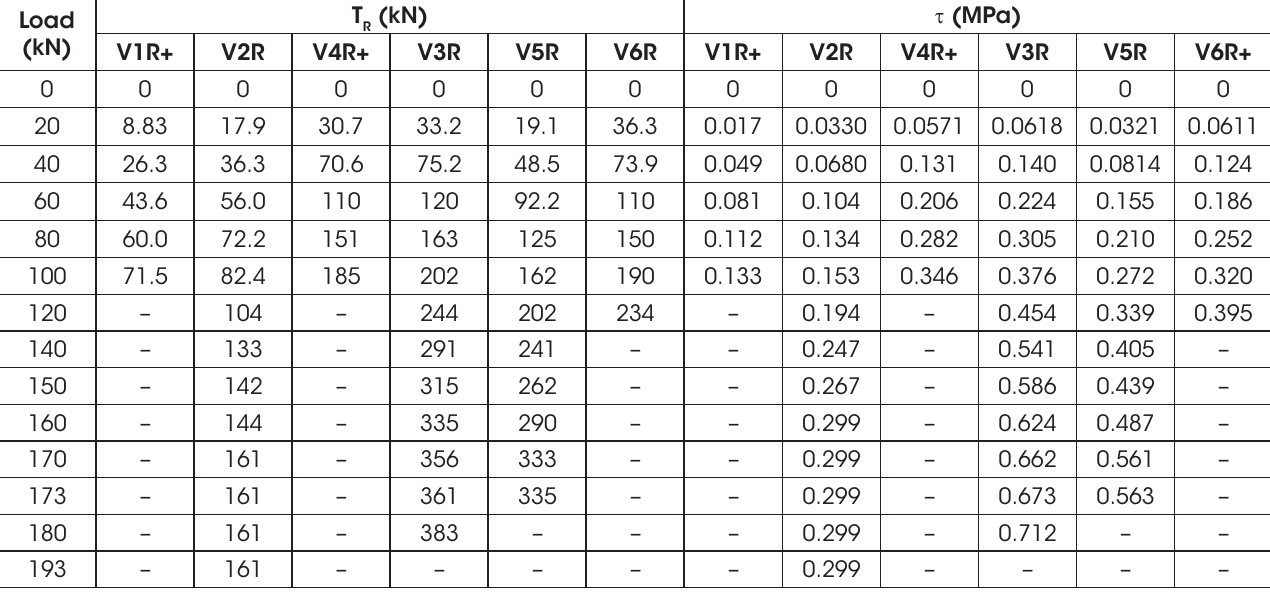
Longitudinal force and nominal shear stress at the beam-jacket interface during final static loading